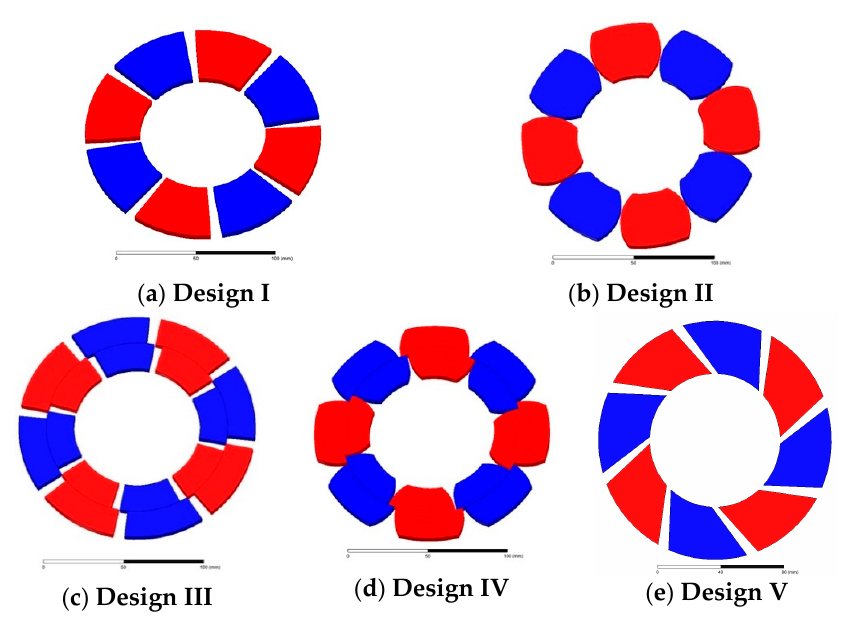
Figure 6. The researched designs of the magnets.